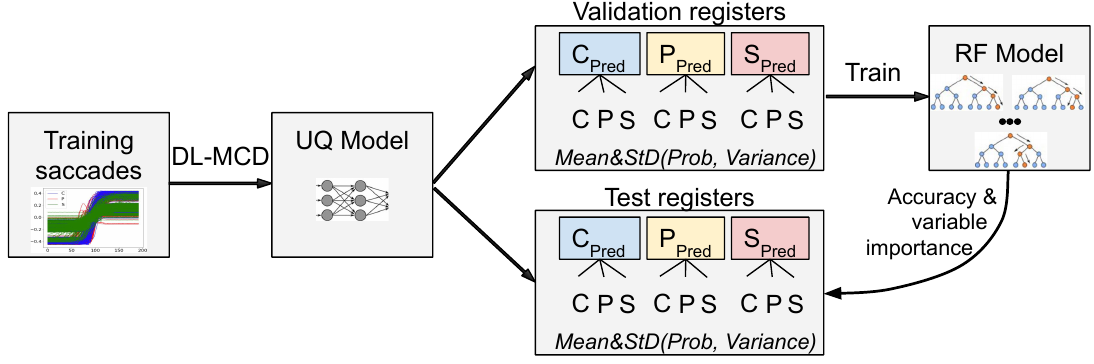
Figure 2. Overview of the proposed